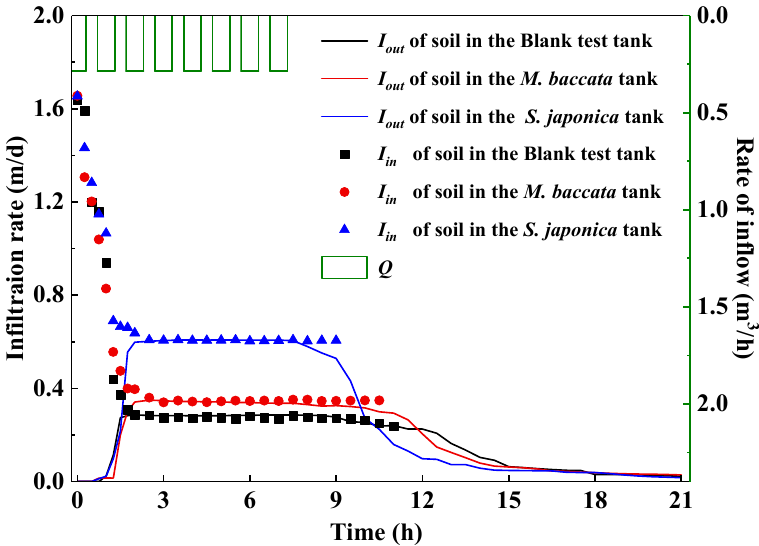
Figure 5. Variation in the soil infiltration rates over time in the three different test tanks. Values of water inflow ( I in ) and outlet flow ( I out ) are shown. ( Q is the rate of inflow to the test tank)